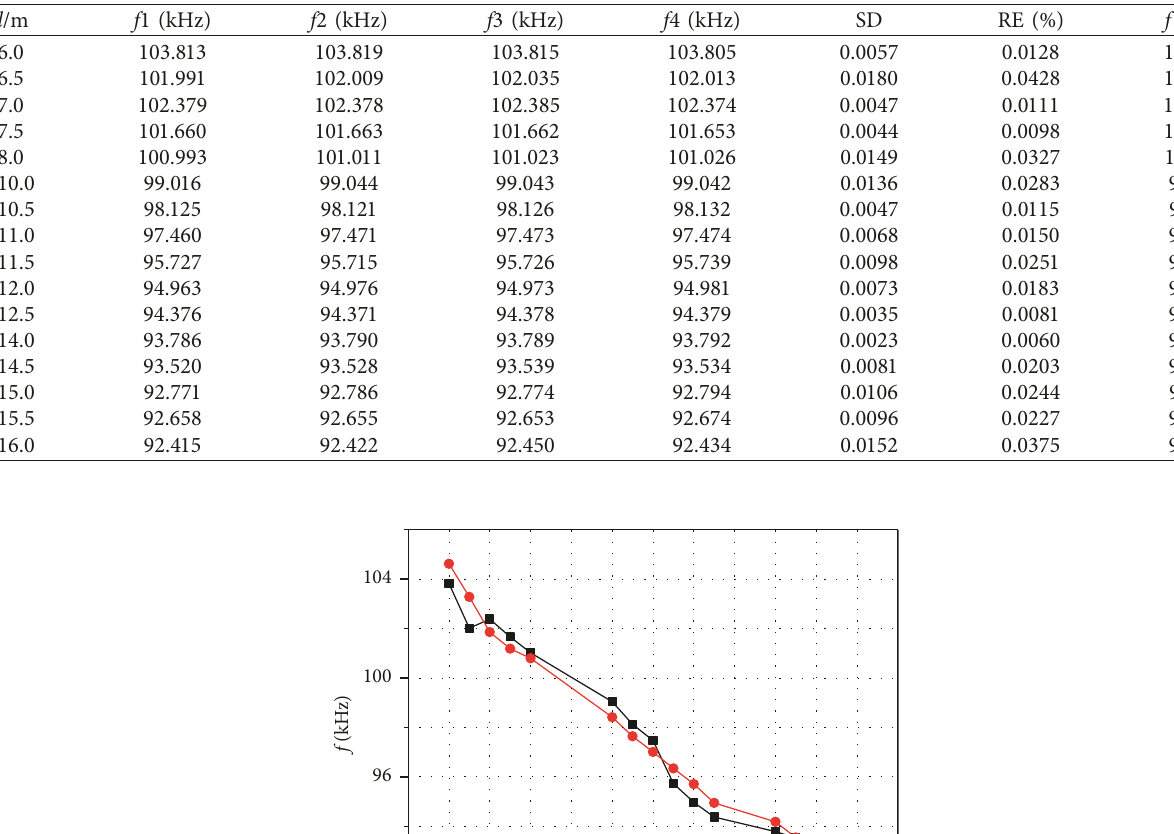
Table 3: V 9mm experimental data of steel strands.